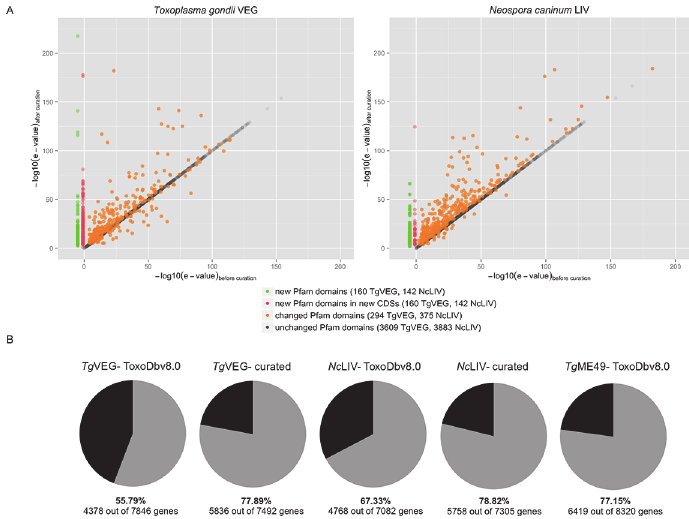
Fig 2. Qualitative and quantitative assessment of manually re-evaluated genomes. (A) We took confidence scores of Pfam domain hits (Pfam database v 26.0) as a rough indicator of the annotation quality and compared the e-value scores of Pfam domains before and after curation. Repetitive domains were omitted and the copy with the lowest e-value score is used for comparison. A 10-fold change in the e-value was considered as a significant change. While the e-values of Pfam domains in unchanged genes remain the same, we find a general increase in Pfam domain hit significance (decreasing e-values) after our curation (orange). We also find new Pfam domain hits appearing in the corrected genes (green) and in newly created genes (red). (B) Quantitative assessment of manual curation. Functional domain content of a genome is a crude indicator of annotation quality; therefore we compared the proportion of genes having a domain hit from InterProScan (grey) to genes without any domains (black). We find a ~20% increase in genes with functional domains after curation in Tg VEG and ~10% in Nc LIV